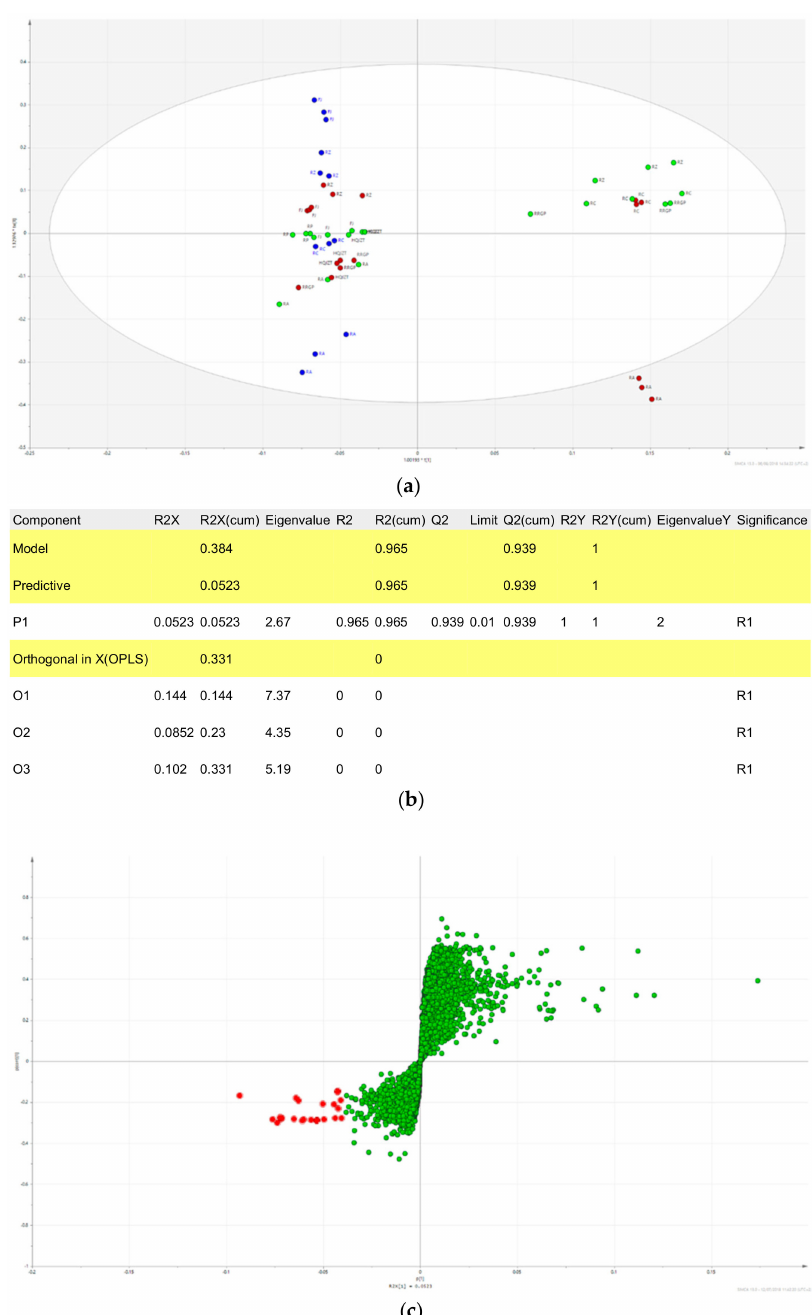
Figure A4. OPLS-DA model using the data from the UPLC-QTOF-MS and pharmacological analysis on inhibition of IFN- γ production (active vs. inactive extracts). ( a ) t[1] / t0[1] Score scatter plot; ( b ) model window; ( c ) S-plot; Hit compounds are marked in